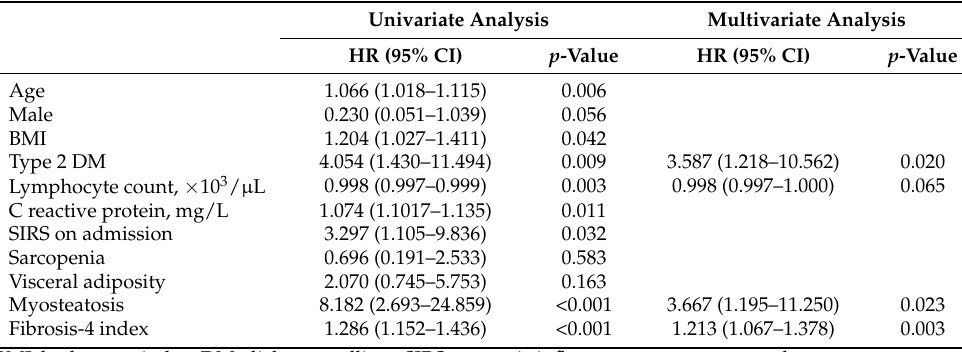
Table 3. Cox regression analysis for predicting mortality of